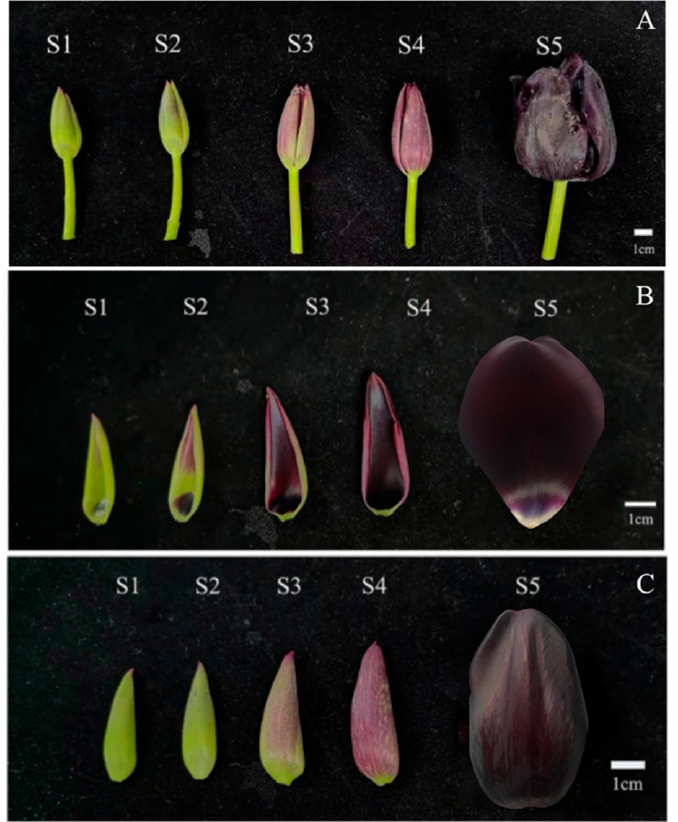
Figure 1. The phenotype of flower color in five different stages of ‘QN’. ( A ) Whole flower, ( B ) Inner petal, ( C ) Outer petal. S1: Green bud stage; S2: Coloring stage; S3: Budding stage; S4: Complete coloring stage; S5: Blooming stage.